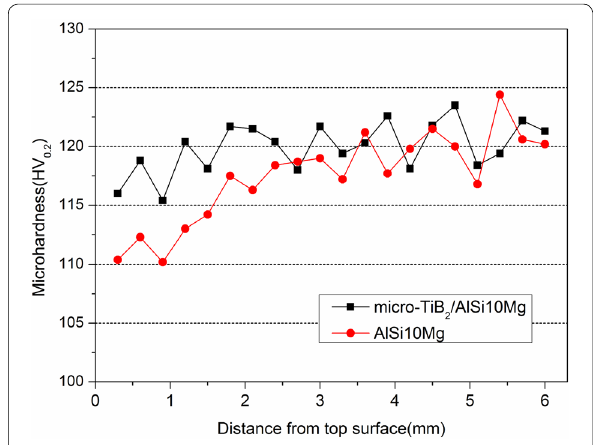
Figure 9 Microhardness distributions of SLM-processed unreinforced AlSi10Mg and micro-TiB 2 /AlSi10Mg composite parts along the building direction